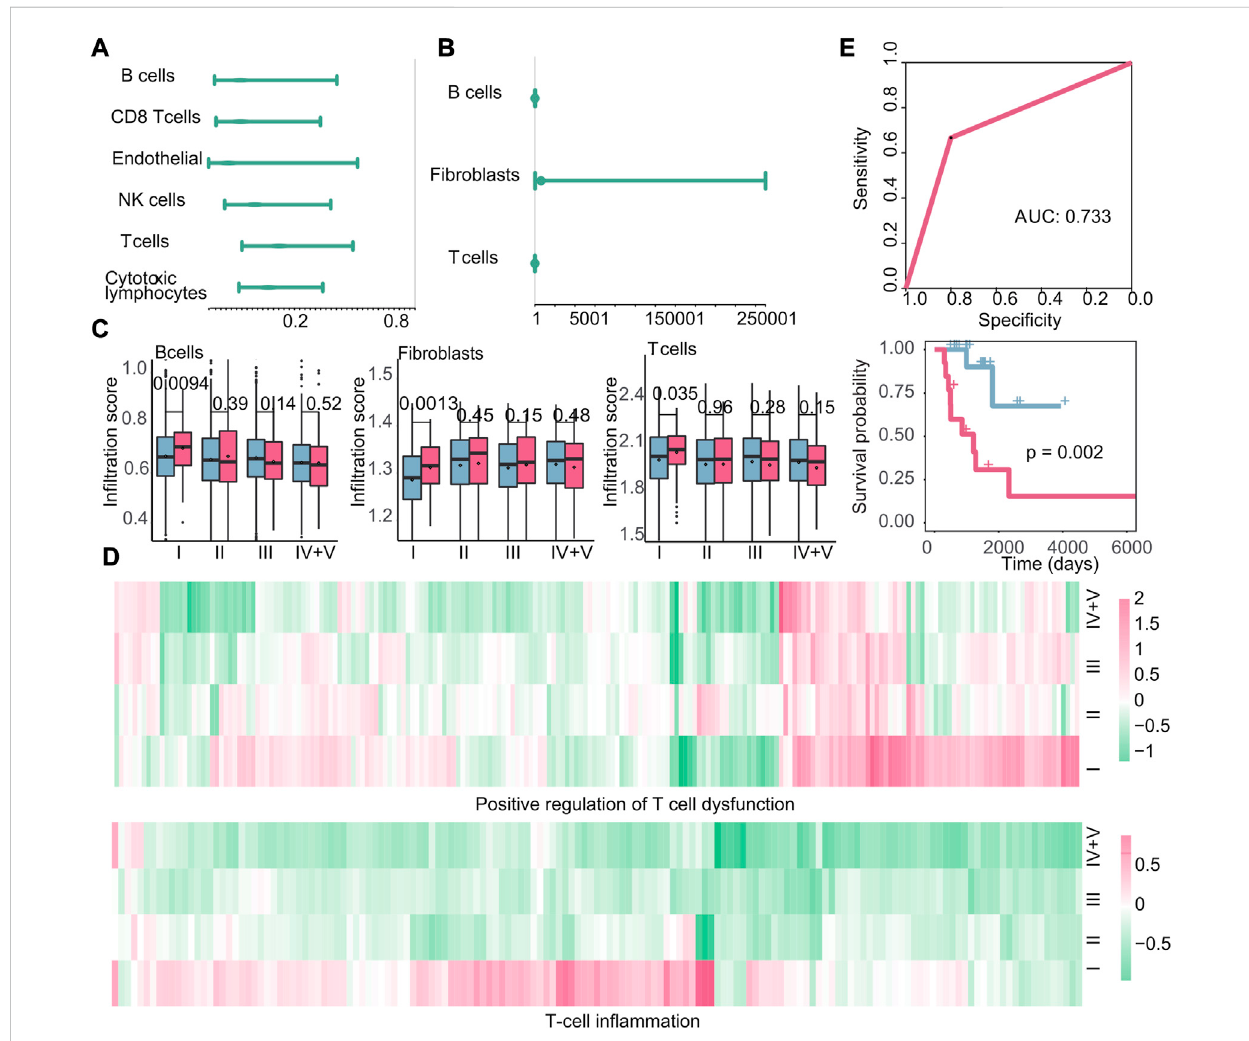
FIGURE 8 Immune microenvironment and immune characteristics. (A – B) Cox regression analysis of immune cell in fi ltration in recurrent tumors or metastatic tumors. At this time, the endpoint event was the generation of new tumors. The dot represents the hazard ratio, and having a value greater than 1 represents the promotion of new tumors. (C) : Boxplots of the in fi ltration of B cells, fi broblasts, and T cells in primary and metastatic tumors at various stages. Blue is the primary tumor, and red is the metastatic tumor. (D) Heatmap of log2FC values of genes related to positive regulation of T-cell dysfunctionandgenesrelatedtoT-cellin fl ammationcalculatedbasedongeneexpressiondata. (E) Basedonthein fi ltrationofthethreetypesofcells,the ROC curve of the classi fi er constructed by k-nearest neighbors and the Kaplan – Meier survival curve of the result of the classi fi er. Red indicates samples predicted to develop metastasis, and blue indicates samples predicted to have no